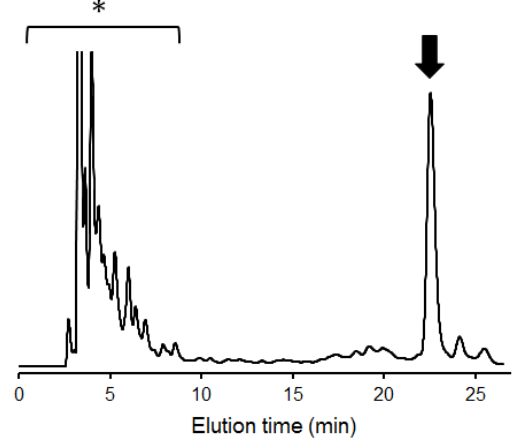
Figure 2. Elution profile of the pyridylamino (PA) derivative of N -linked oligosaccharides derived from the engineered S. cerevisiae cells on an Amide-80 column. The fraction indicated by the arrow corresponds to the PA derivative of Man those indicated by an asterisk contain no detectable